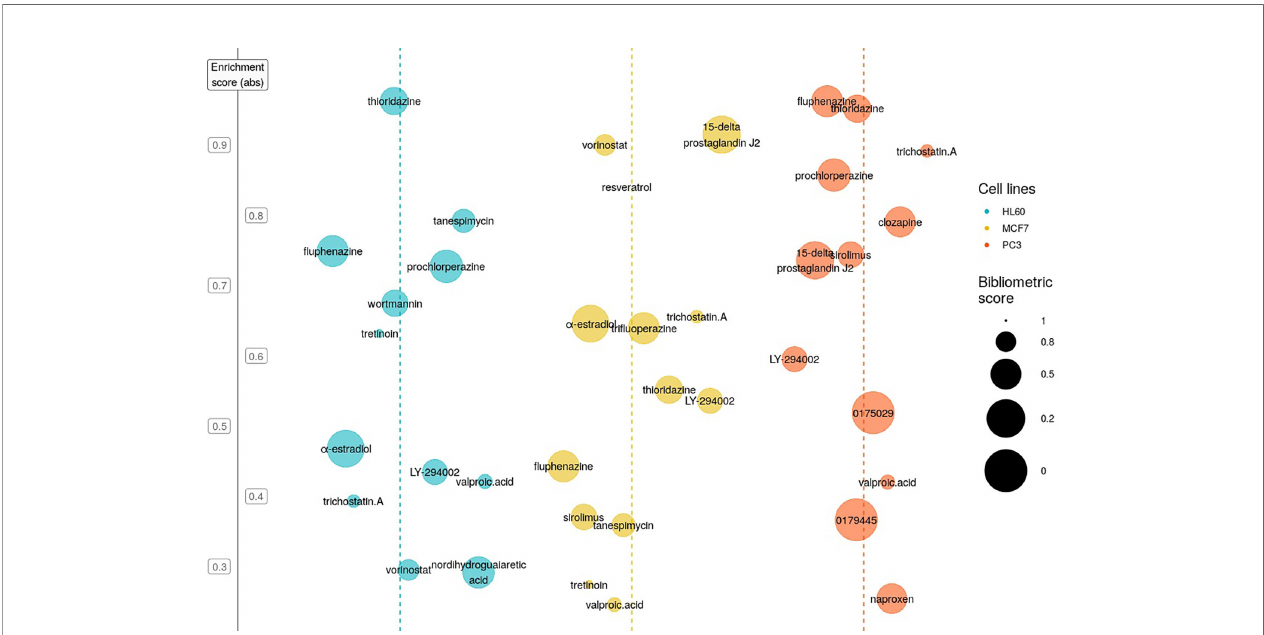
FIGURE 4 | Selection of potentially T-cell Acute Lymphoblastic Leukemia (T-ALL) active molecules using Connectivity Map (CMAP) and CMAPViz. CMAPViz bubble plot for the top hit molecules resulting from CMAP analysis after applying statistical cut offs. Hit molecules are sorted horizontally by cell line data (blue: HL60, yellow: MCF7 and orange: PC3) and vertically by absolute enrichment value. We applied horizontal jittering to avoid overlap in the representation. The size of the circle for each molecule is inversely proportional to the bibliometric